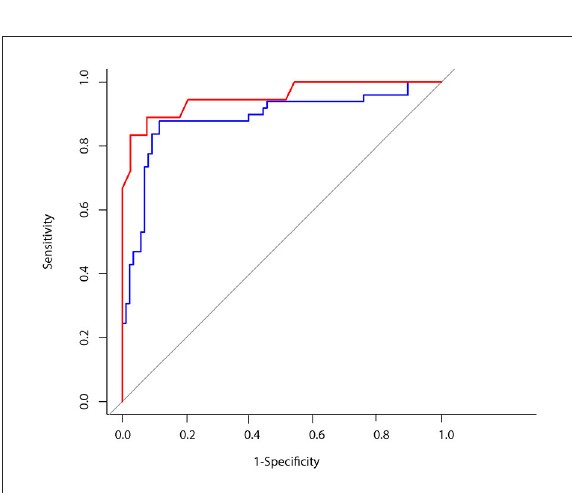
FIGURE3 Blue line: ROC CURVE using artificial intelligence for head impulse test interpretation AUC: 0.88. Red line: ROC CURVE using VOR gain to predict a vestibular stroke AUC: